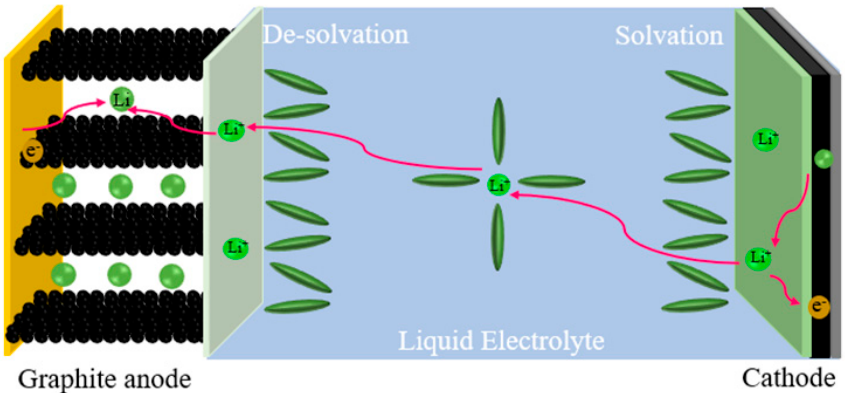
Figure 1. Schematic illustration for charging a Lithium-ion battery.